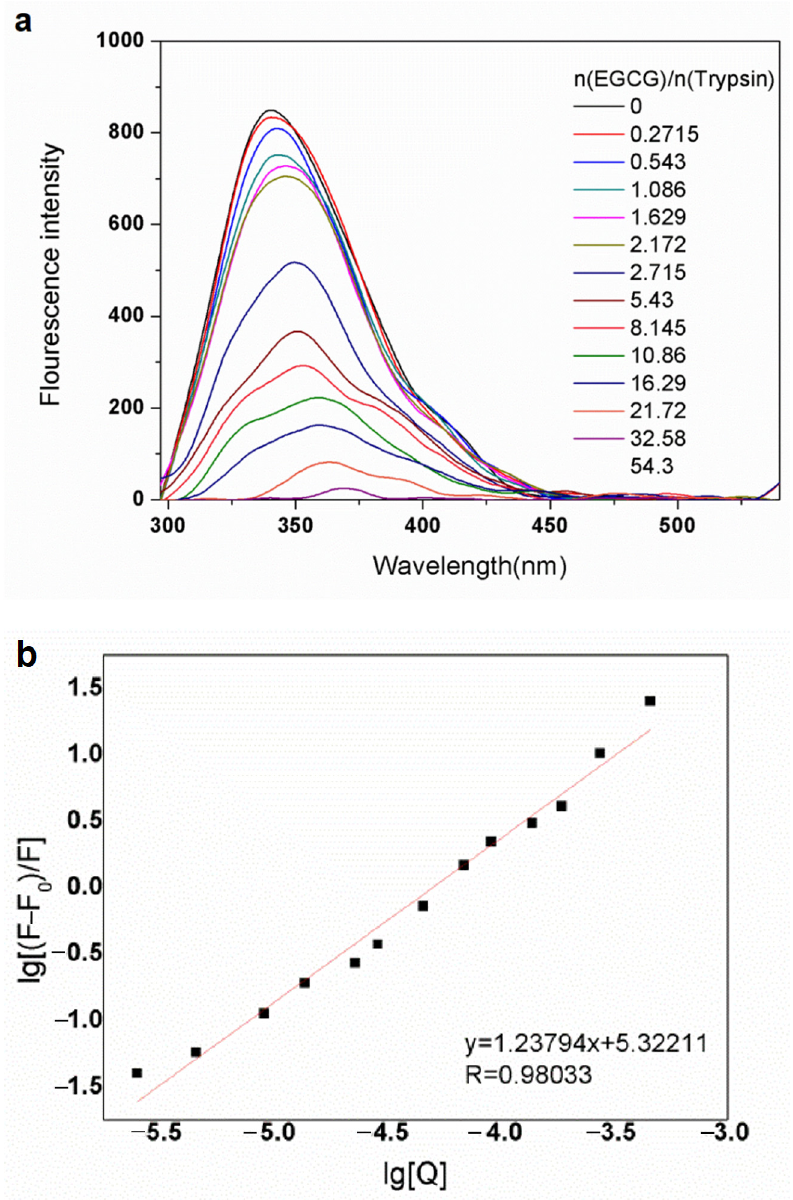
Figure 1. ( a ) Quenching effect of EGCG on trypsin fluorescence intensity as a function of EGCG concentrations. ( b ) The relationship between different concentrations of EGCG and fluorescence intensity can be described by the modified Stern–Volmer equation.